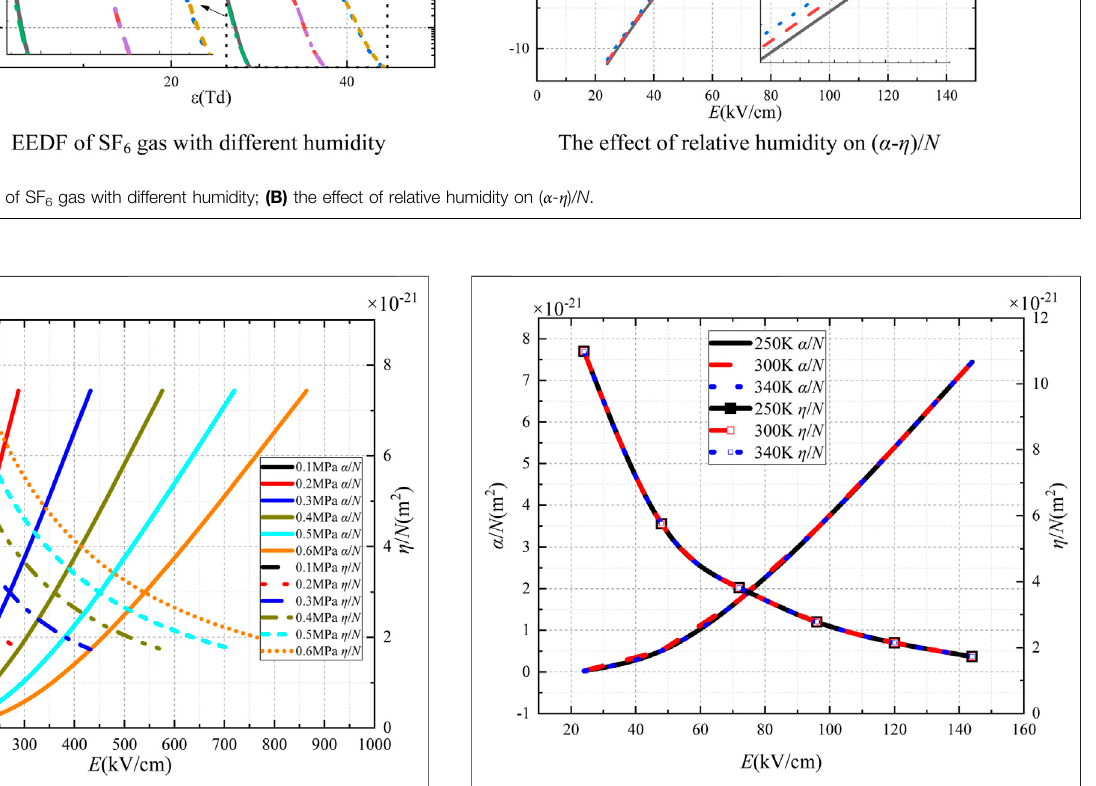
FIGURE 4 | α / N and η / N versus E with the temperature of 250 – 340